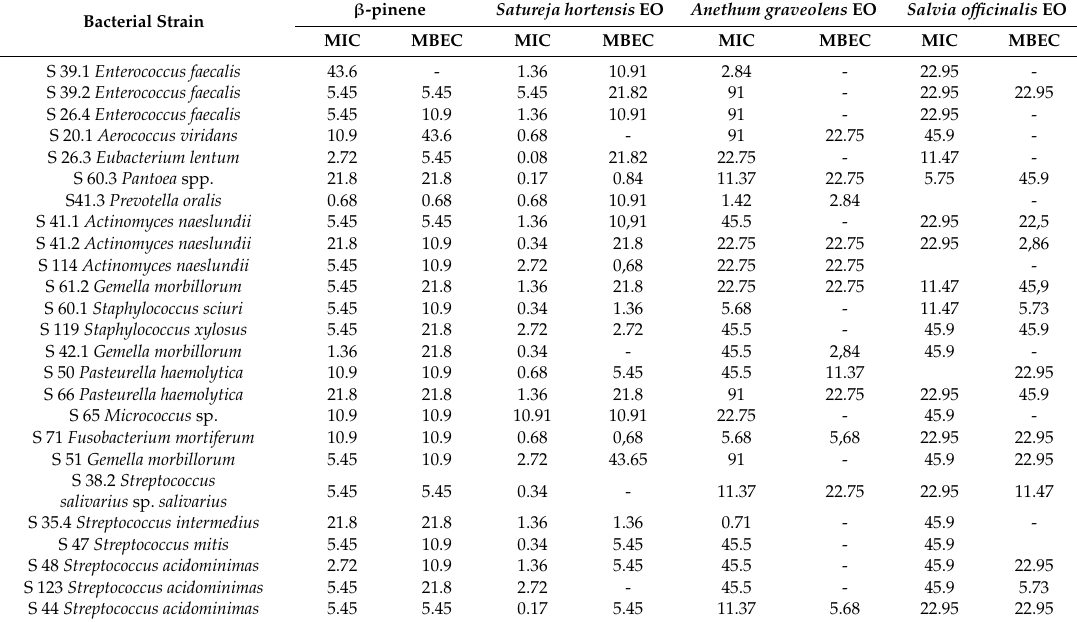
Table 1. Antimicrobial activity of essential oil–minimum inhibitory concentration (EO–MIC) (mg / mL) values and minimal concentration for biofilm eradication (MBEC) (mg / mL) values. β Bacterial Strain